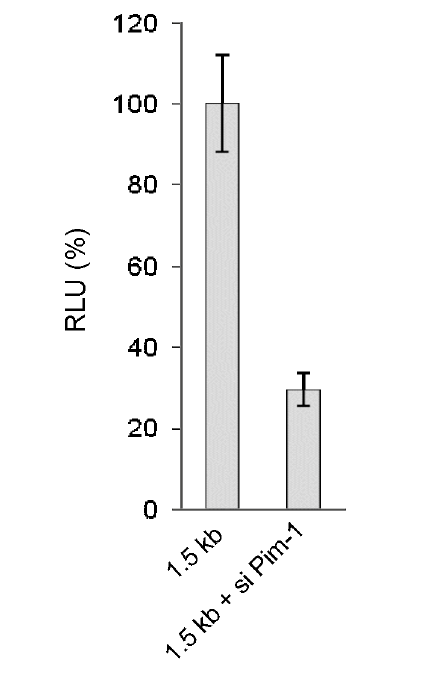
Figure S4. Effect of an siRNA-mediated Pim-1 knockdown on promoter activity of the ~1.5 kb reporter construct in HeLa cells. RLU values were derived from 5 independent triplicate experiments (+/ − S.D.). RLU values for the control (left bar, transfected with the reporter plasmid but in the absence of a siRNA) were set to 100%. Lipofectamine transfection of HeLa cells was done as described under Supplementary methods, with the following alterations: 2 × 10 5 cells were used, and 40 pmol (0.6 µg) siRNA plus 0.5 µg of ® the reporter plasmid were combined in 50 µL Opti-MEM I medium and mixed with ® I medium. The resulting mixture 1.5 µL Lipofectamine™ 2000 in 50 µL Opti-MEM (~100 µL) was incubated for 20 min at room temperature to allow complex formation before addition to the cells. For the control (left bar), the siRNA was